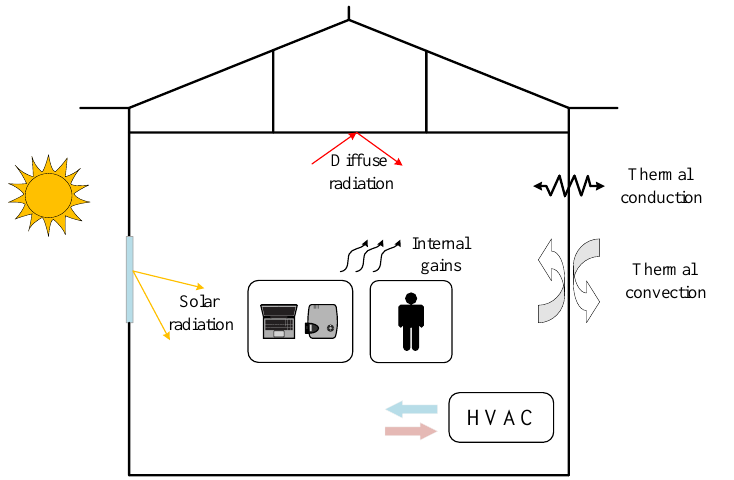
Figure 1. Simplified thermal phenomena in buildings.